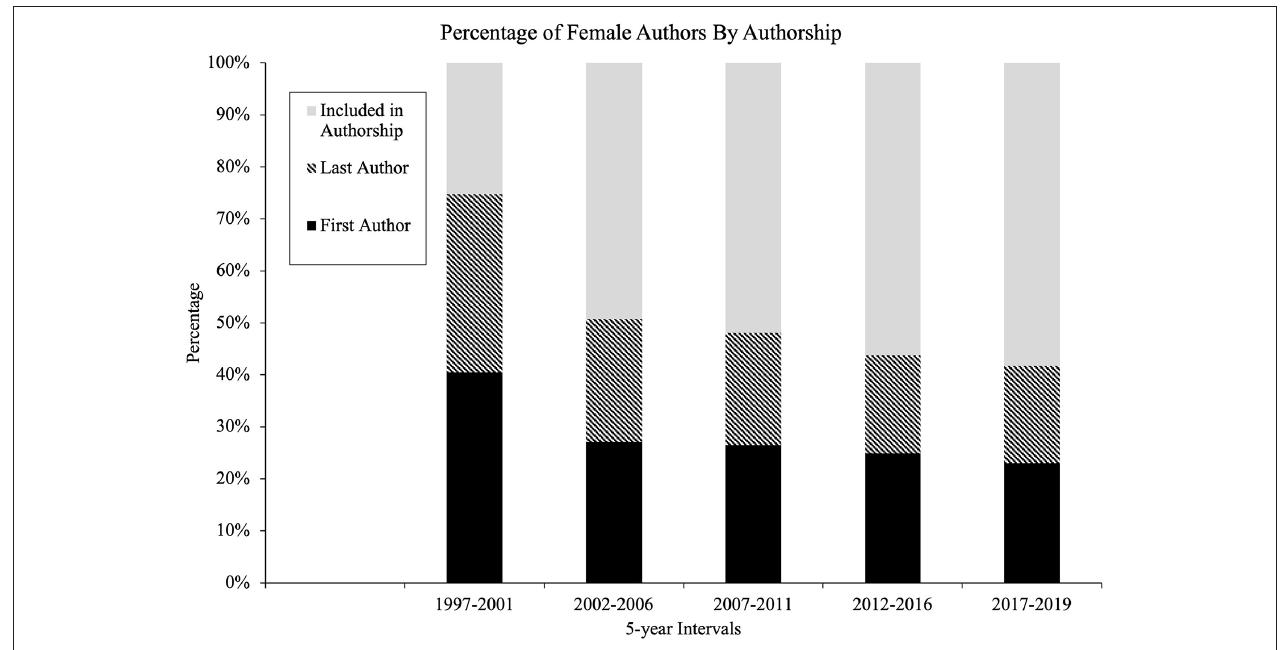
FIGURE 1 | Total percentage of female authors over time by